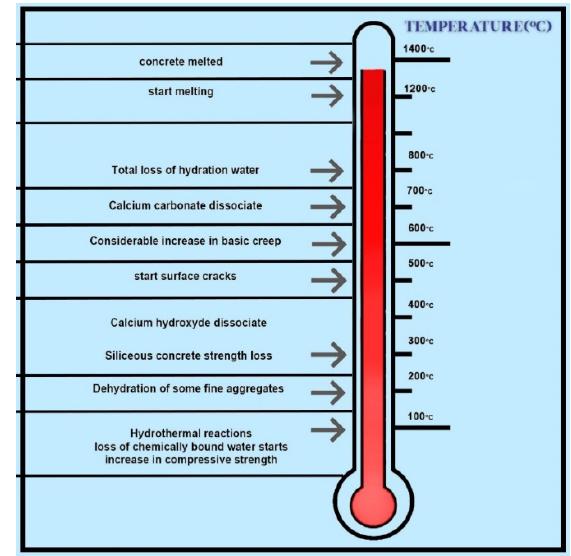
Figure 1. Physicochemical processes in Portland cement concrete during